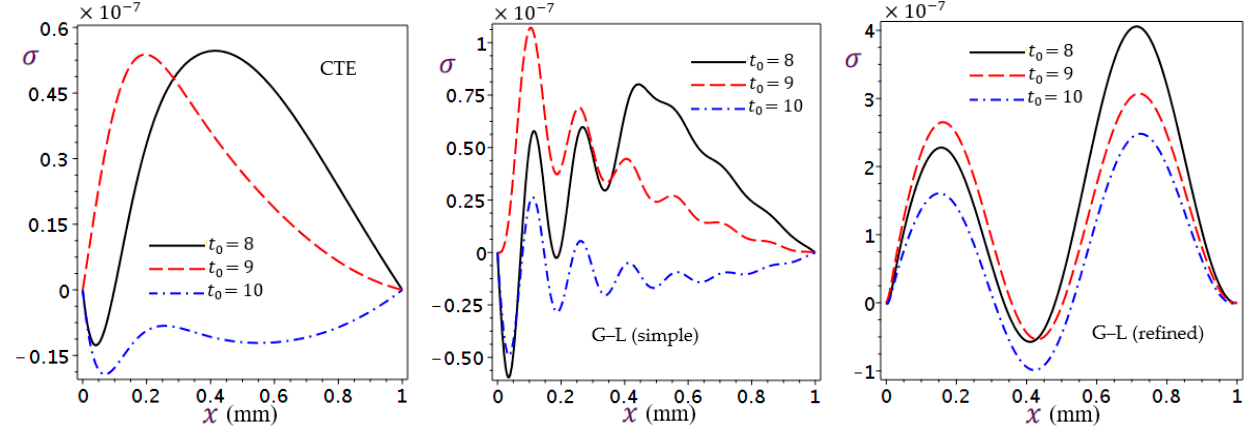
Figure 9. Effect of ramp-type heating parameter 𝑡 (cid:2868) on normal stress 𝜎 .